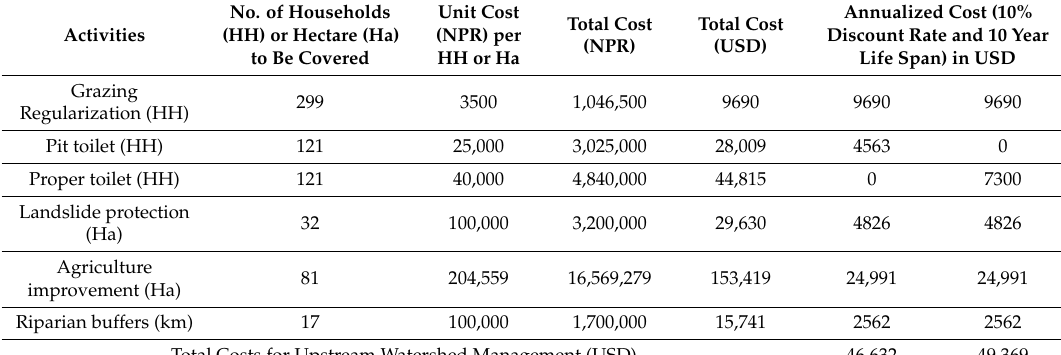
Table 5. Costs of interventions in upstream